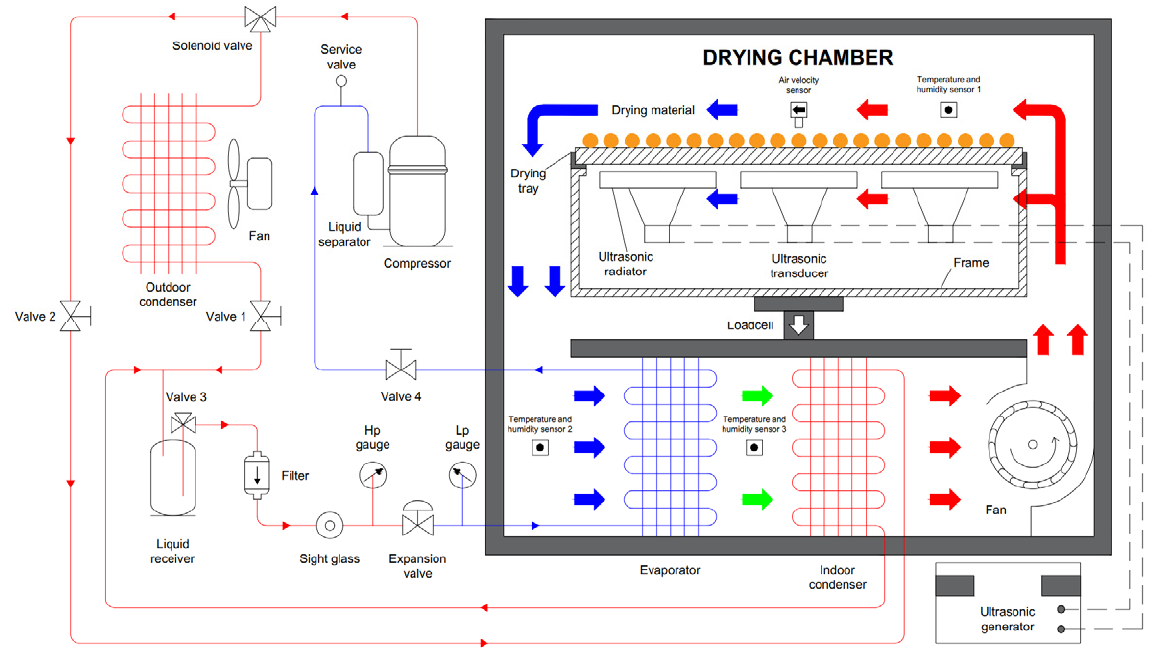
Figure 1. Schematic diagram of drying process.